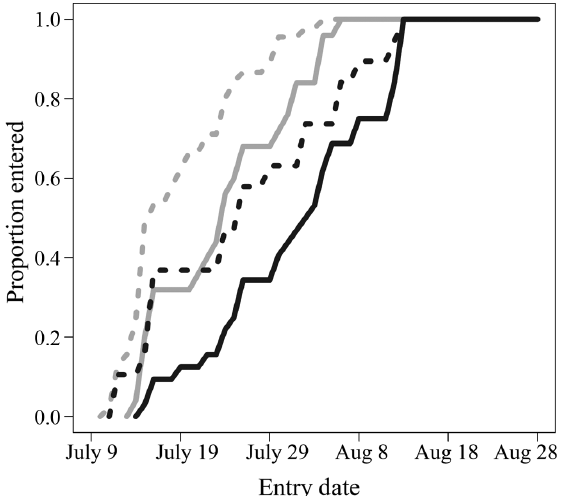
Fig. 2. Cumulative proportion of chum salmon entering Sawmill Creek across the 2015 spawning season. Dashed lines: males; solid lines: females. Grey: natural-origin salmon; black: hatchery-produced salmon